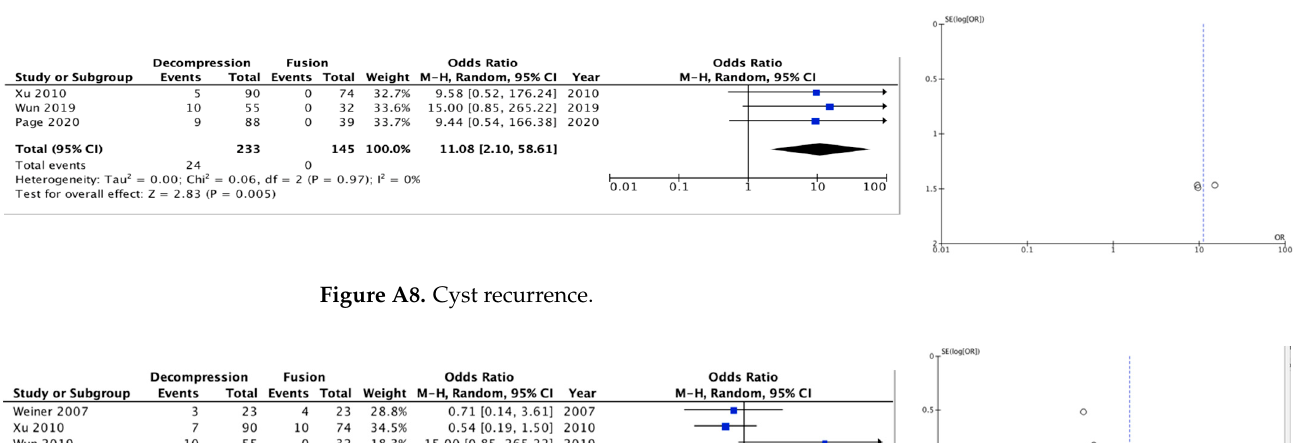
Figure A7. Pre-op spondylolysthesis.